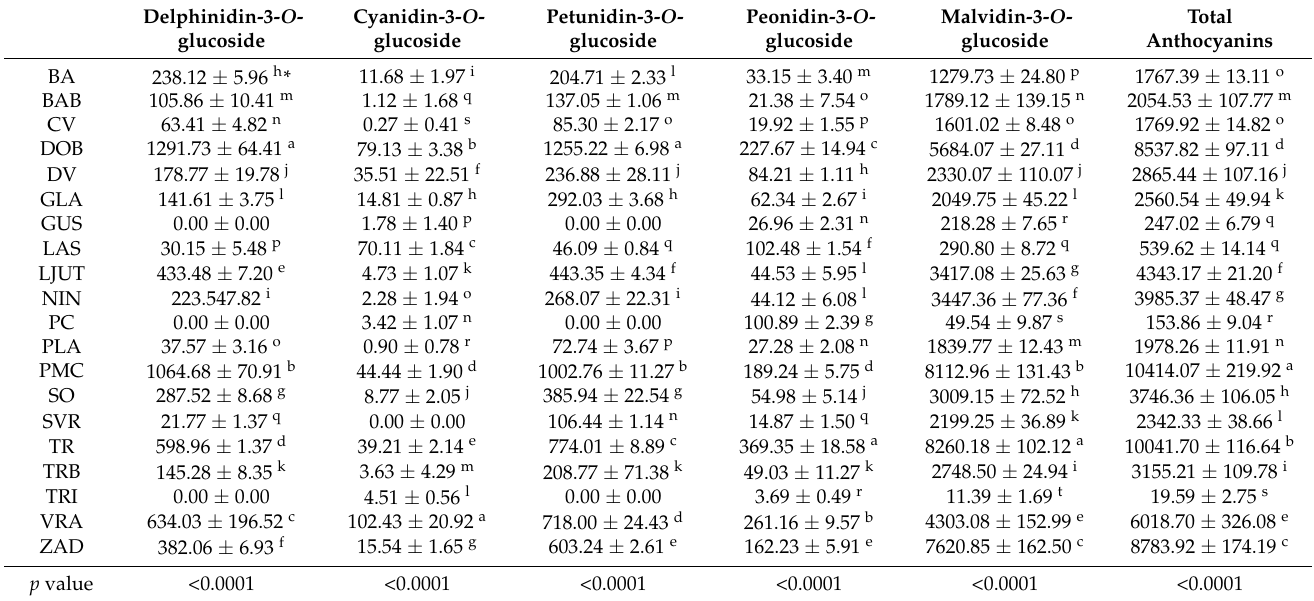
Table 1. Anthocyanin profile of Croatian autochthonous grape